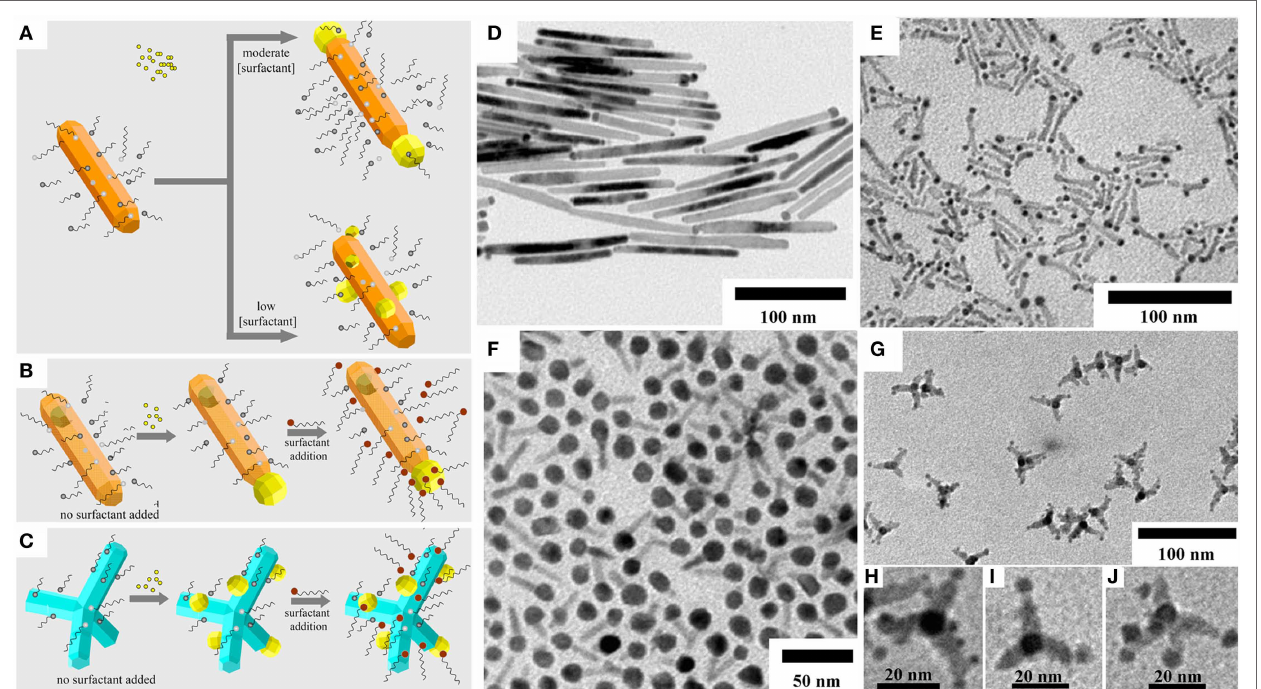
FIGURE 8 | Examples of anisotropic magnetic heterostructured nanocrystals (MHNCs) synthesized by surfactant-controlled regioselective heterogeneous nucleation on preformed nanorod and branched seeds . (A–C) Sketch of the mechanism [adapted from Carbone and Cozzoli (2010), copyright 2010, with permission from Elsevier]; (D–J) Low-magnification transmission electron microscopy galleries of: (D) dumbbell-like heterostructured nanocrystals (HNCs) made of Au-tipped Co nanorods [reproduced from Wetz et al. (2007) with permission, copyright Wiley-VCH Verlag GmbH & Co. KGaA]; (E) dumbbell-like and matchstick-like Co-tipped anatase TiO 2 nanorods [reproduced from Casavola et al. (2007) with permission, copyright American Chemical Society]; (F) matchstick-like MHNCs made of eccentric CdSe@CdS nanorods tipped with a single Co head [synthesized according to Deka et al. (2009)]; (G–J) HNCs made of multiply Co-decorated γ -Fe 2 O 3 tetrapods [reproduced with permission from Casavola et al. (2009), copyright American Chemical